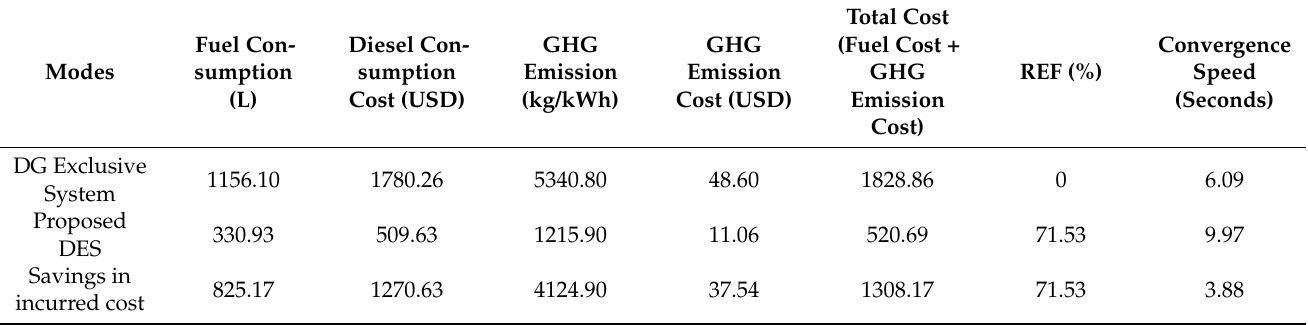
Table 2. Daily operational and emission cost analysis of the DES model under